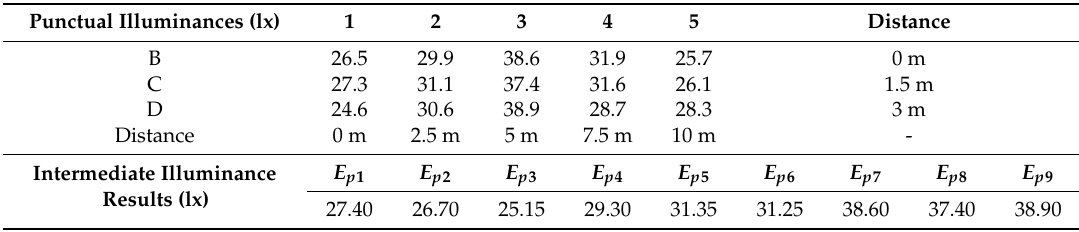
Table 7. High-thickness translucent (B) cover field measurements and calculated parameters ( E pi ) used to obtain E m , U m , and U g